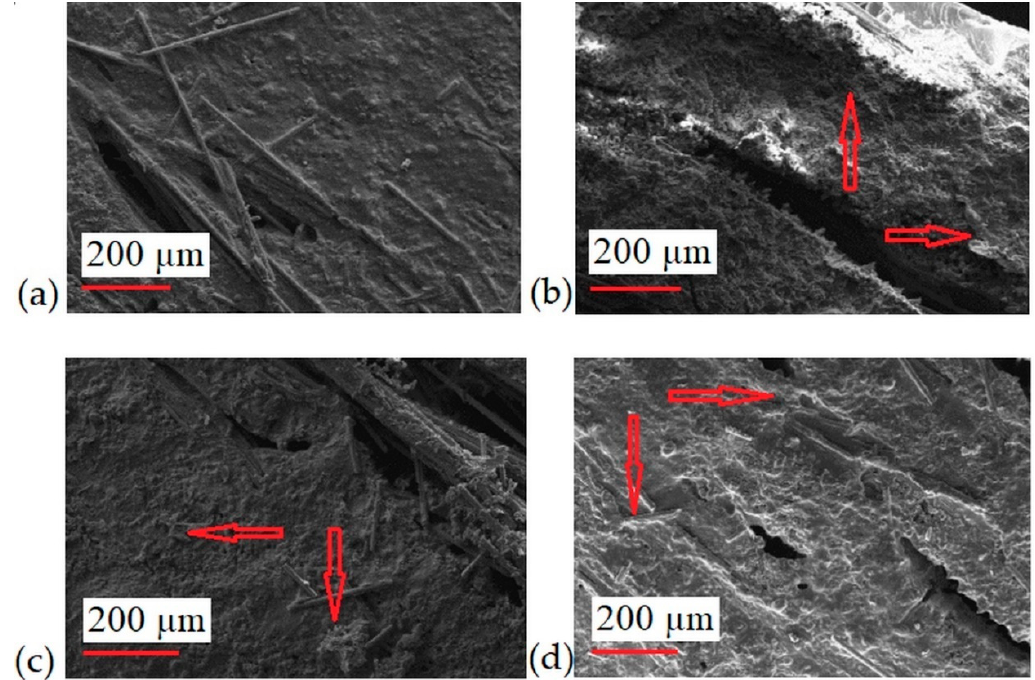
Figure 2. Structure of composites after ILSS test ( a ) 0PVC; ( b ) 2.5PVC; ( c ) 5PVC; ( d ) 10PVC.